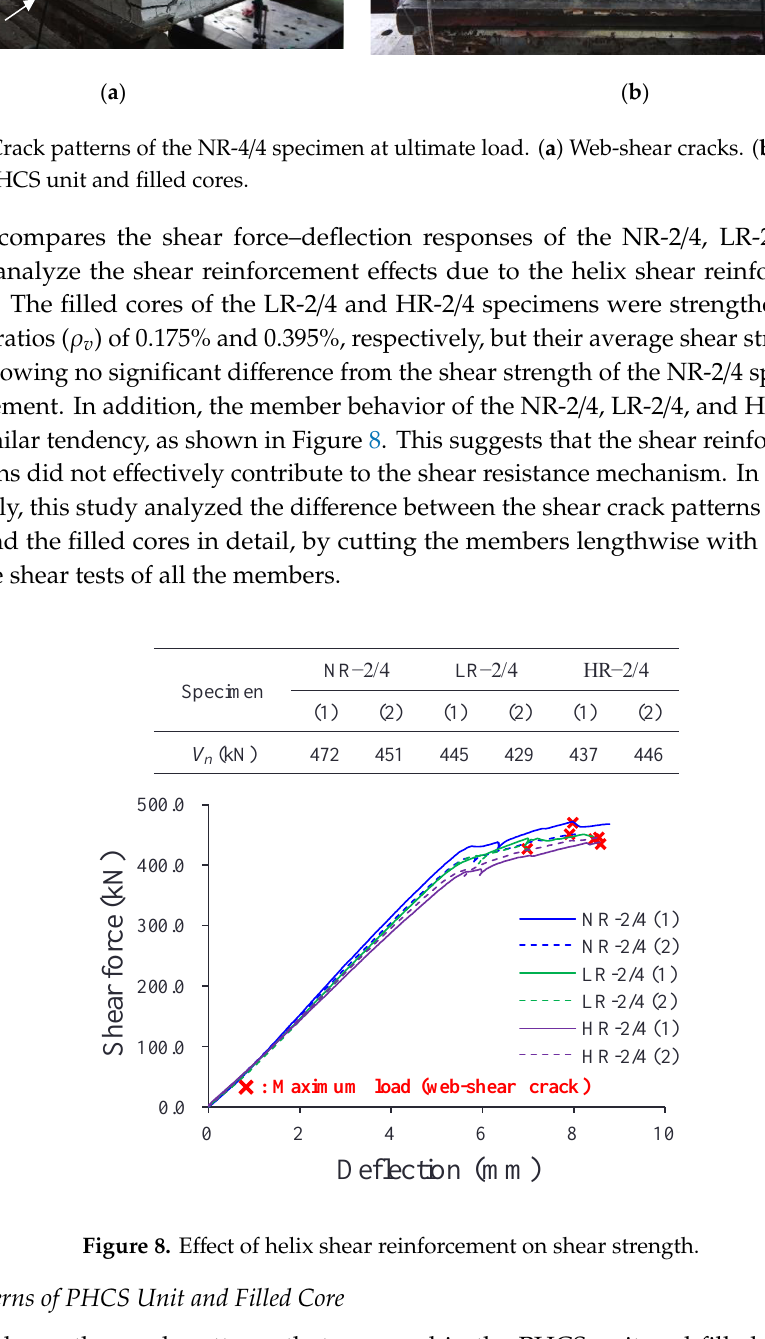
Figure 7. Crack patterns of the NR-4/4 specimen at ultimate load. ( a ) Web-shear cracks. ( b ) Separation between PHCS unit and filled cores.